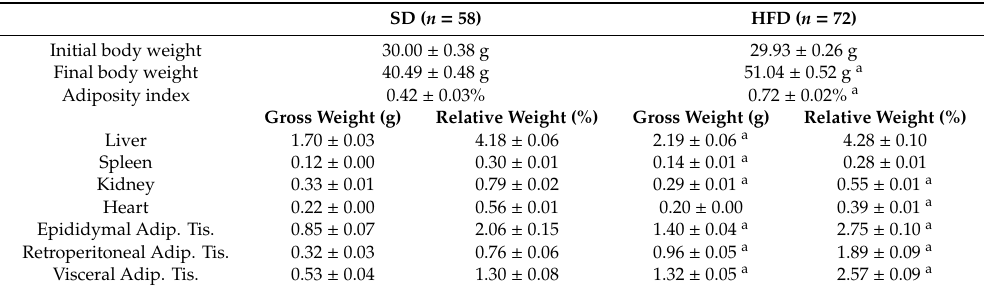
Table 2. Morphometric analysis of male Swiss mice fed with standard diet (SD) or high-fat diet (HFD) after 12